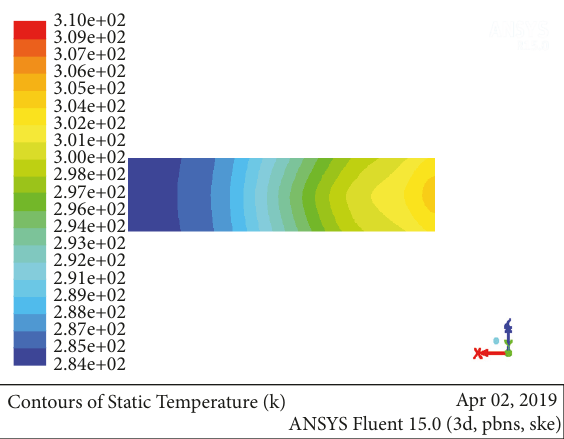
Figure 17: The bottom temperature distribution of support in Test TS1.